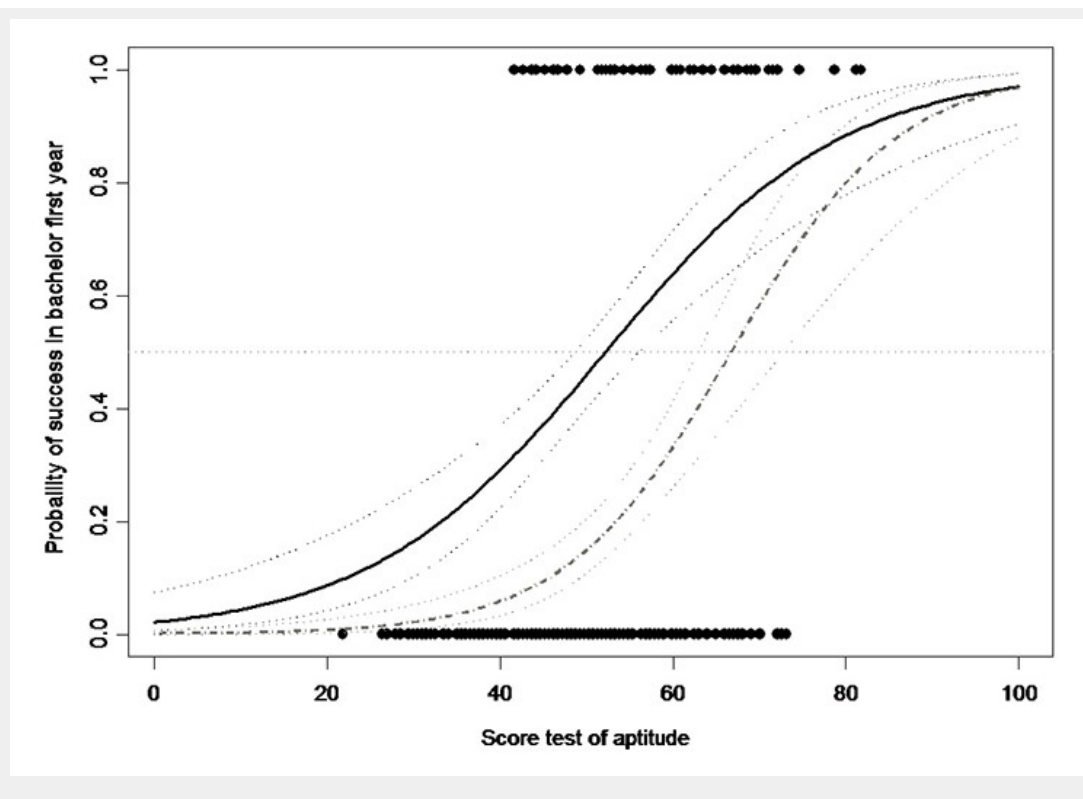
Figure 2 Probability of success during bachelor year 1 as a function of the score at the aptitude test (n = 288). The continuous line is the probability of success after one or two attempts and the dashed line is the probability of success without repeating year 1. The fitted lines obtained with logistic regression models are drawn with 95% confidence